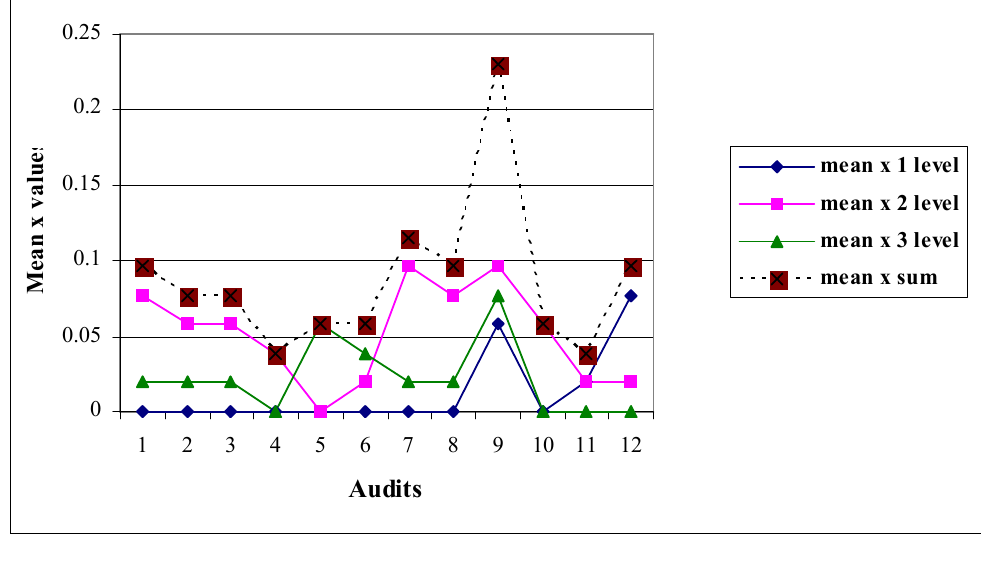
x Fig 8. Mean values during each audit of organization YYY